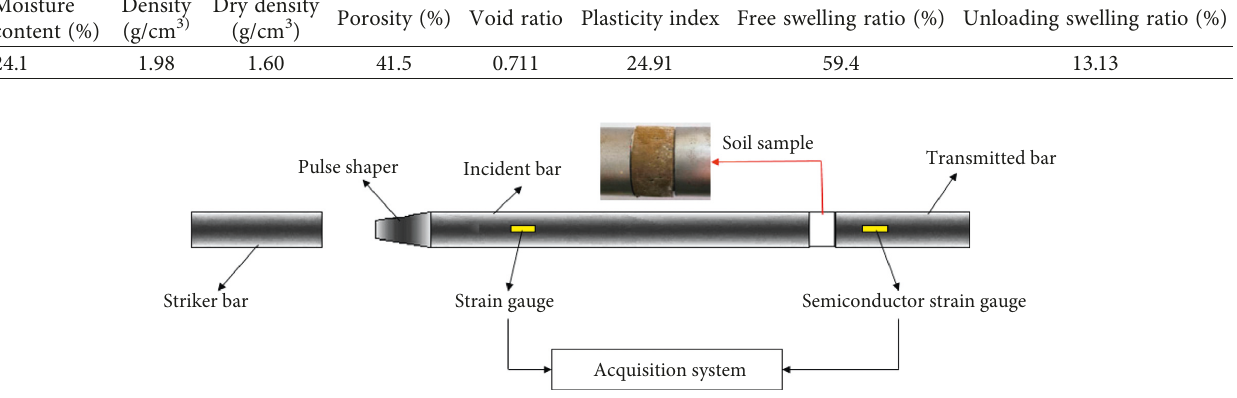
Table 1: Physical parameters of expansive soil.